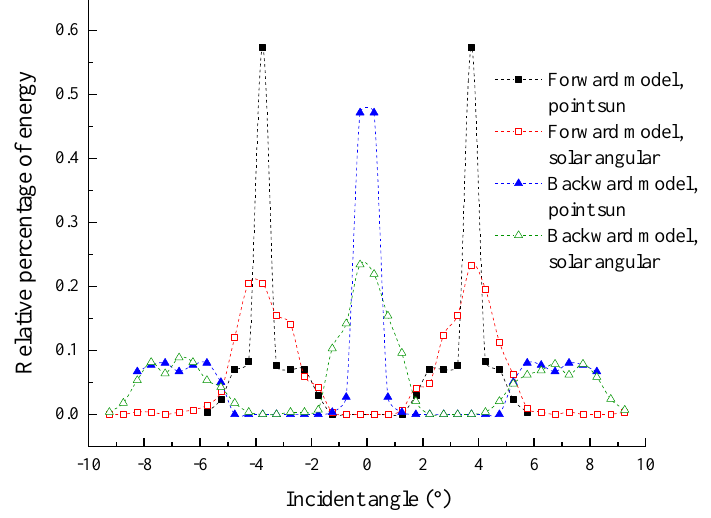
Figure 8. Comparison of the concentrated incident angles between different models.